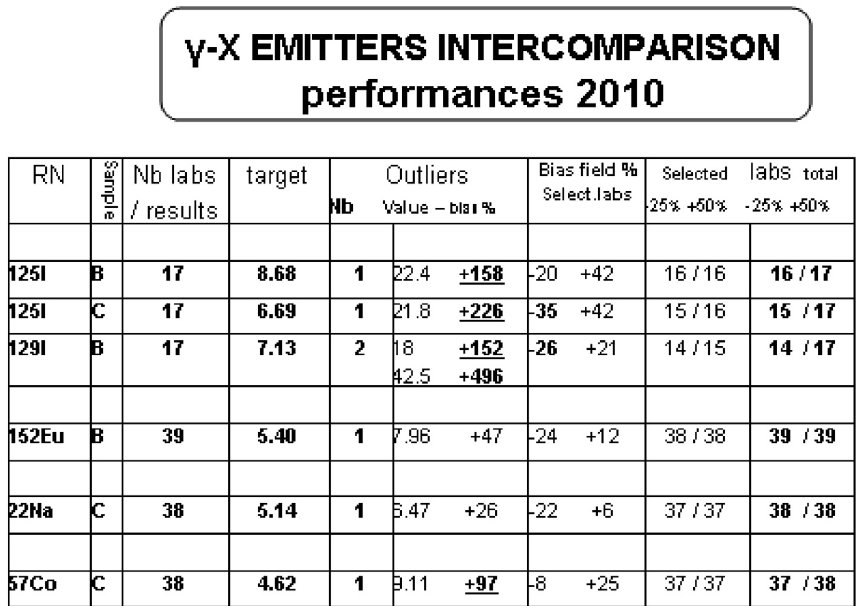
Fig. 7. Global 2010